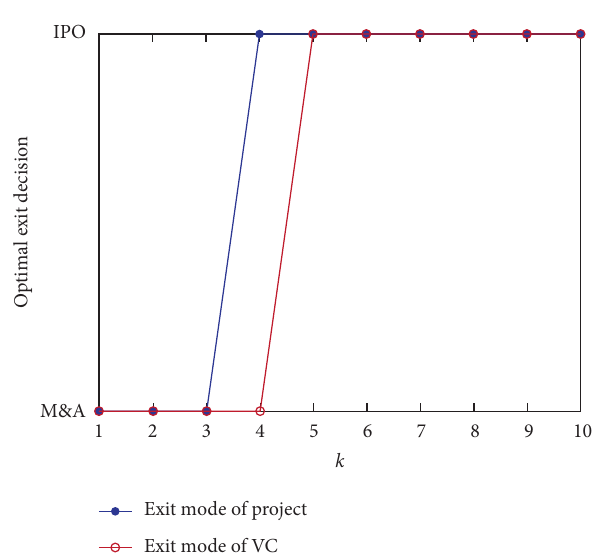
Figure 7: Optimal exit decision ( σ � 4or σ � 7 )